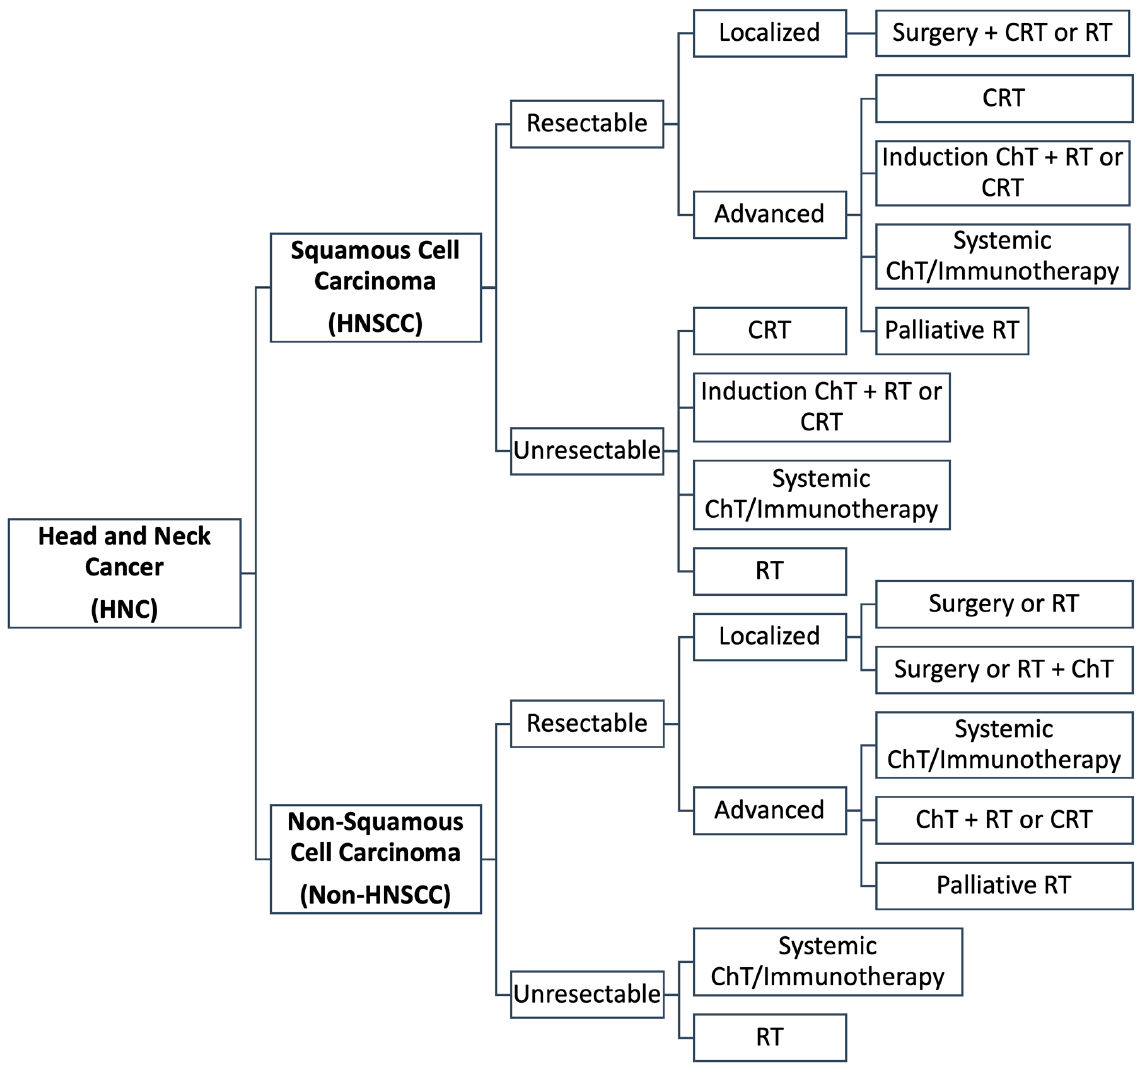
Figure 2. Generalized guidelines for the treatment of HNC (CRT—Chemoradiotherapy, RT—Radi- otherapy and ChT—Chemotherapy)